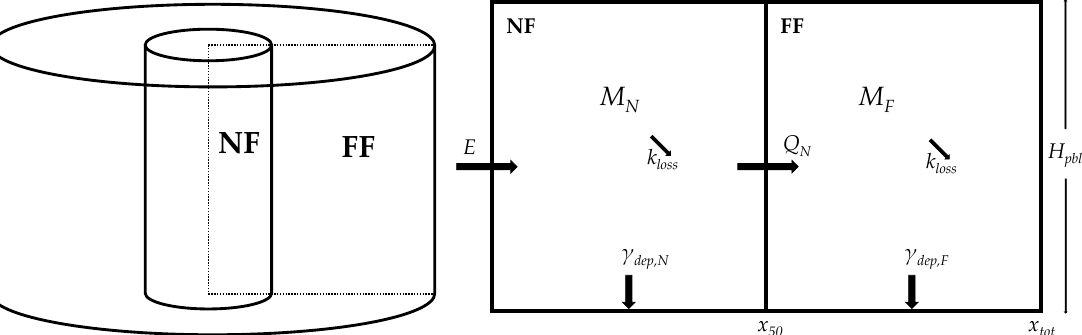
Figure A1. A schematic figure of the two compartment model. The cylindrical NF compartment rests inside the FF with the emission E occurring at the center point of the NF compartment. The boxes on the right illustrate the two compartments from a side view with the bottom being the ground level, whereas the top demonstrating the planetary boundary